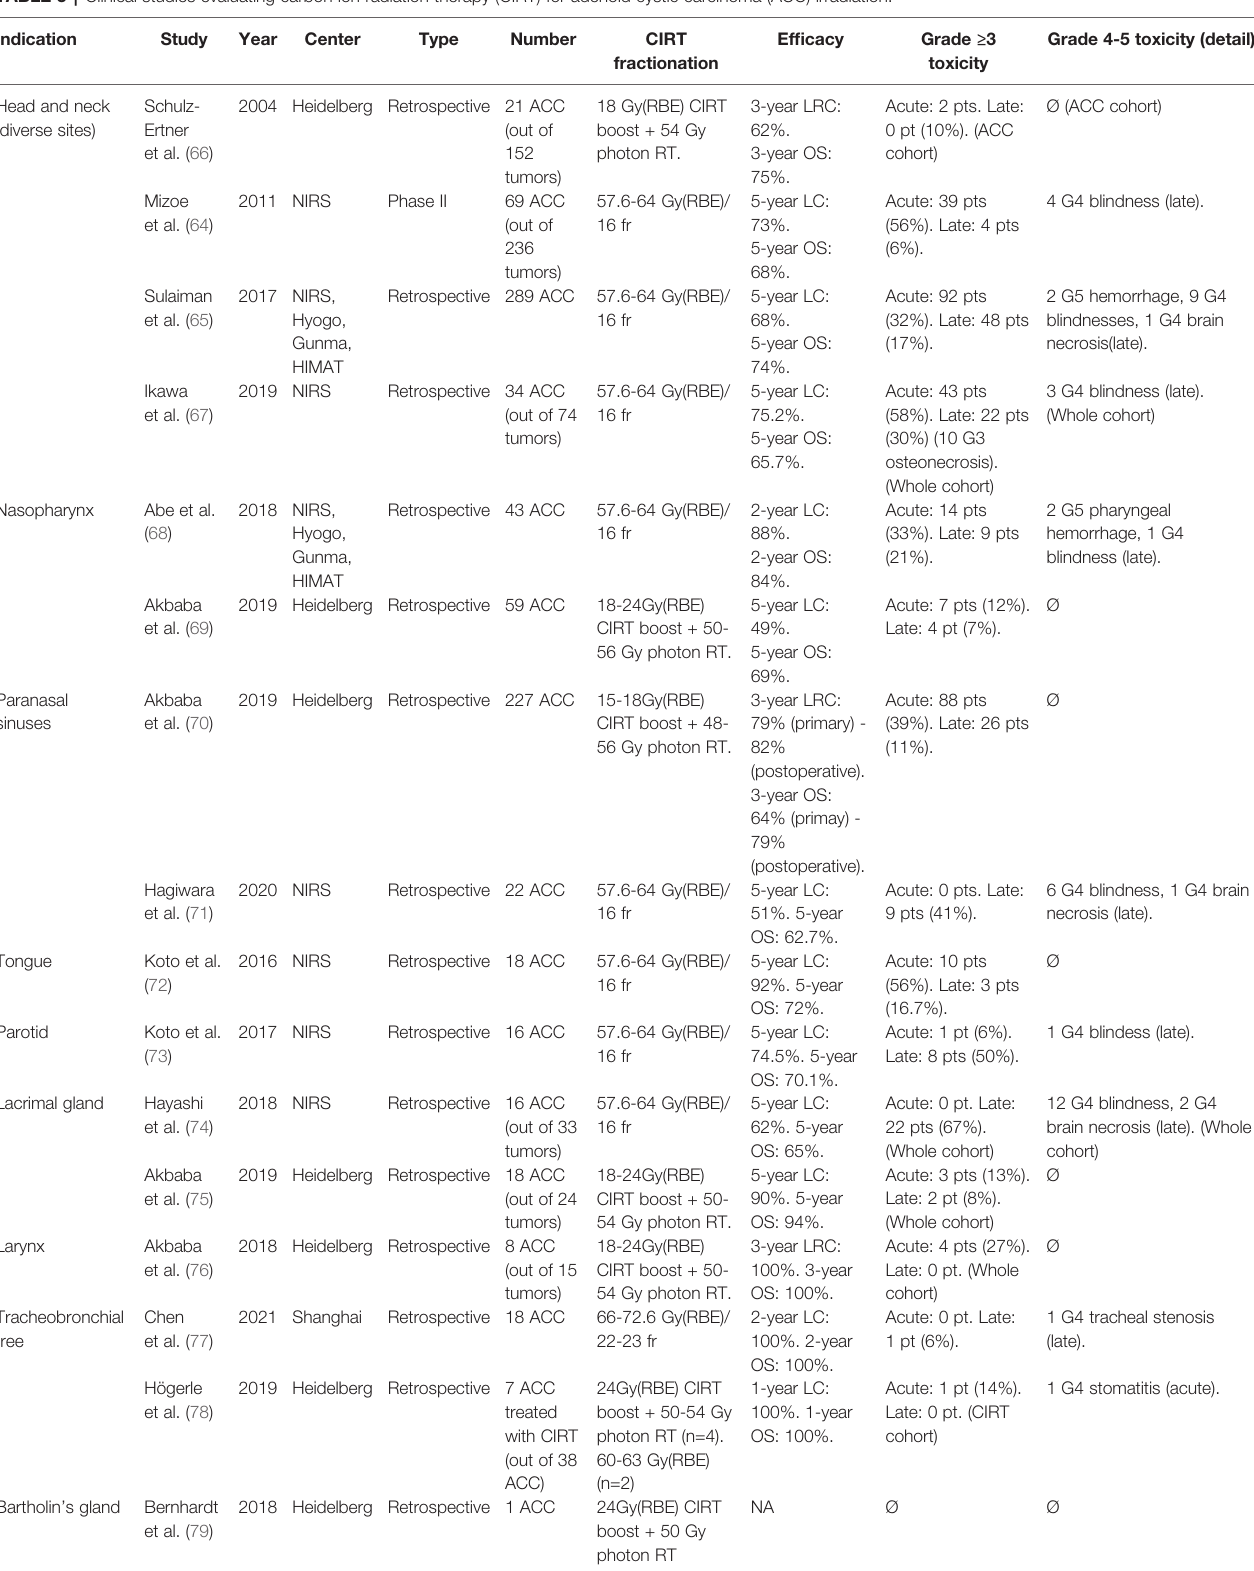
TABLE 3 | Clinical studies evaluating carbon ion radiation therapy (CIRT) for adenoid cystic carcinoma (ACC)